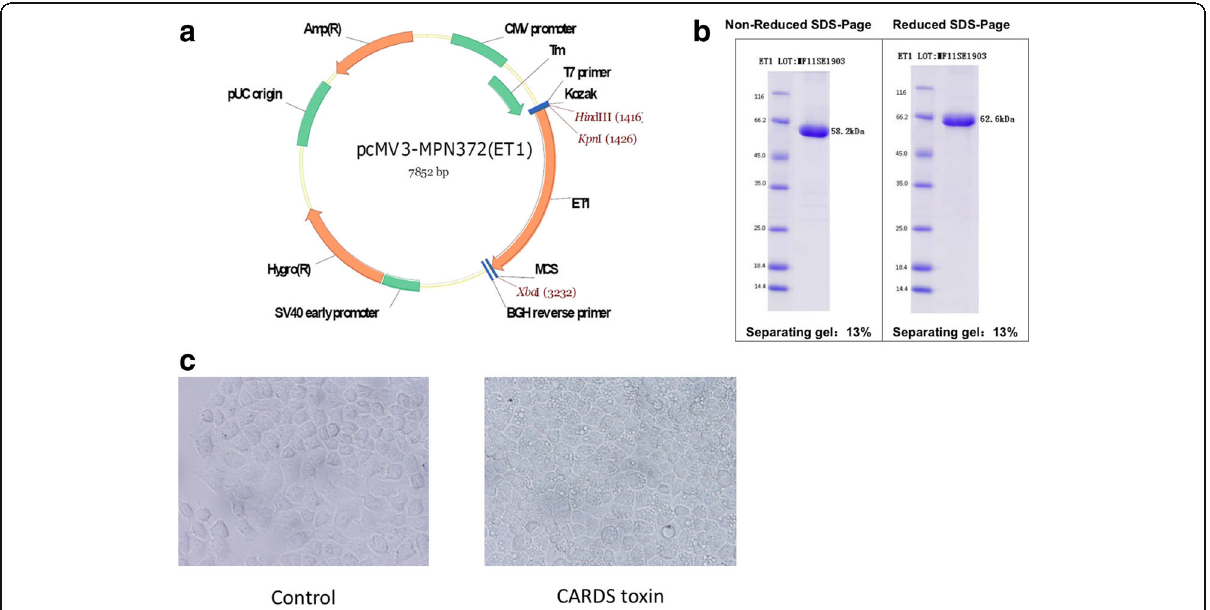
Fig. 4 Plasmid construction and vacuolation activity verification of CARDS toxin. a Schematic diagram of plasmid construction. CARDS toxin gene (MPN372) eukaryotic expression vector was constructed and purified. b Purity of CARDS toxin by SDS-PAGE. c HeLa cells were co-cultured with 50 μ g/mL CARDS toxin or not for 24 h. CARDS toxin exhibited the ability to induce vacuolization in HeLa cells compared with the control